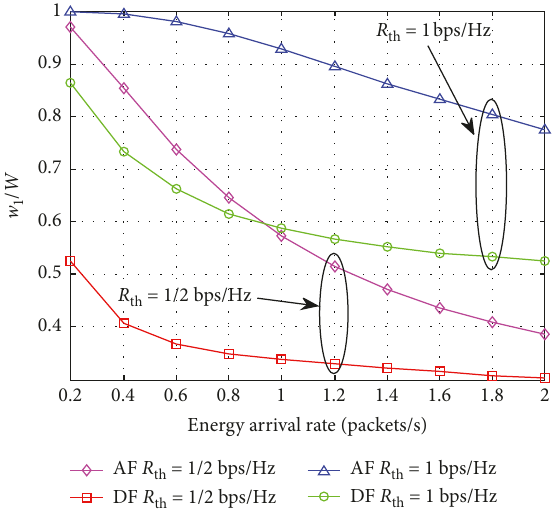
Figure 6: Bandwidth allocation vs. energy arrival rate λ � 1/2, and P � 1W). Figure d 4